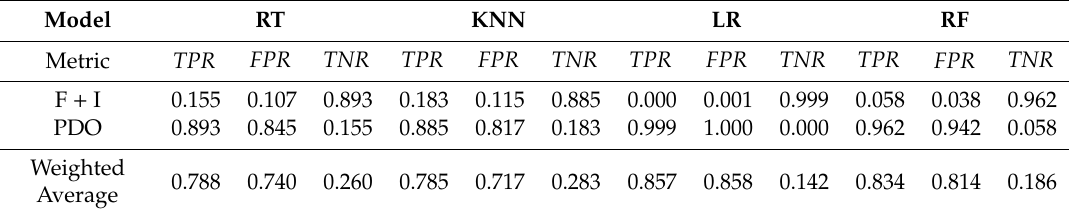
Table 3. TPR , FPR , and TNR of the classifiers with the imbalanced training